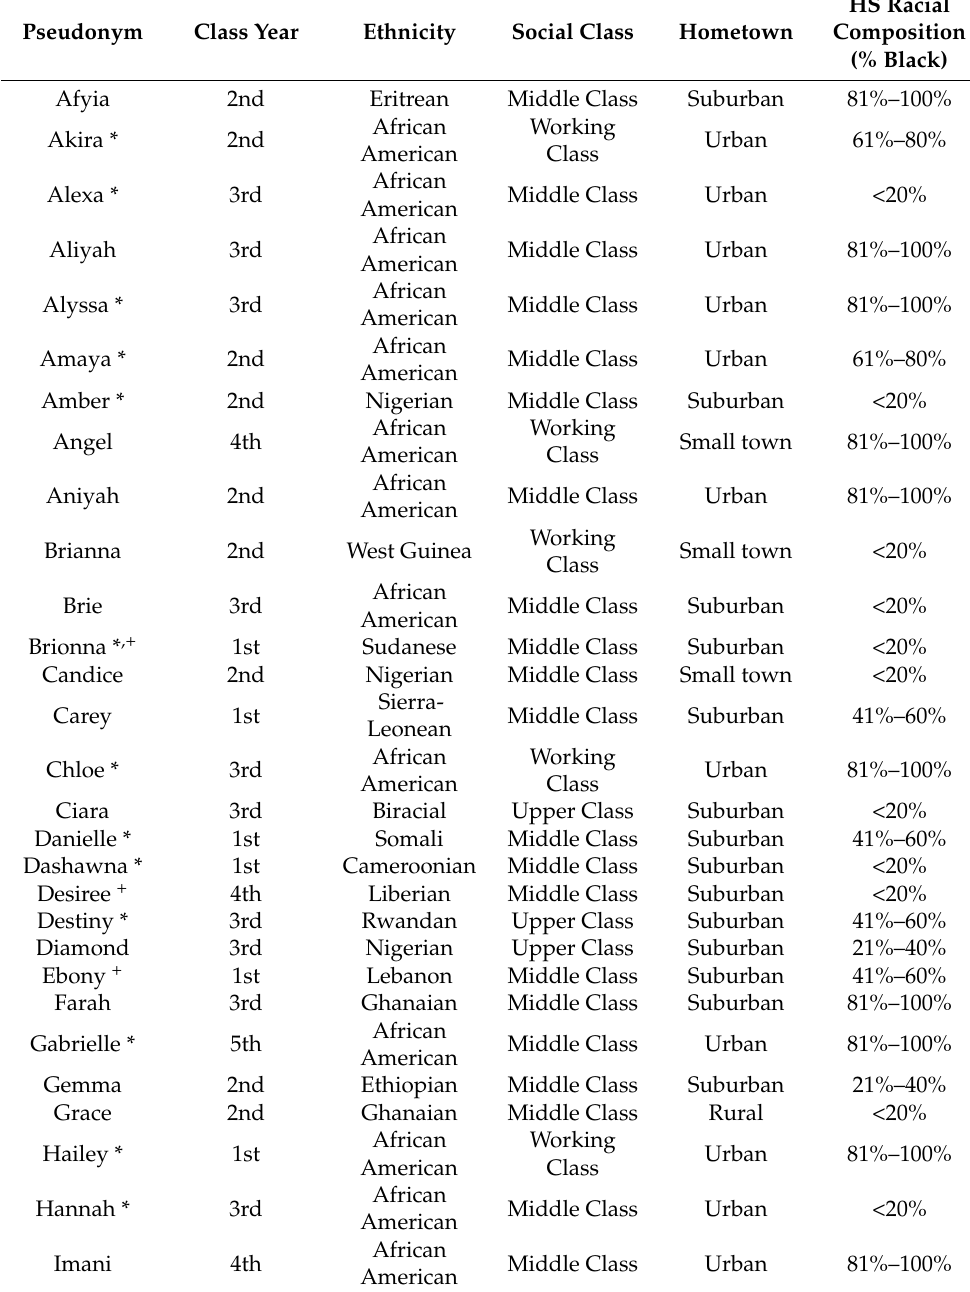
Table 1. Participant demographic